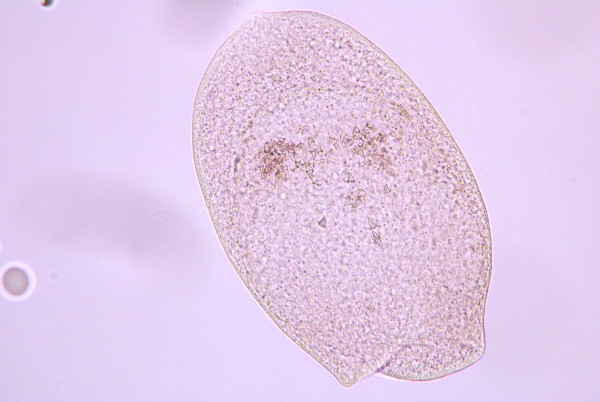
Developmental stage of a metacestode with hooklets starting to become organized.